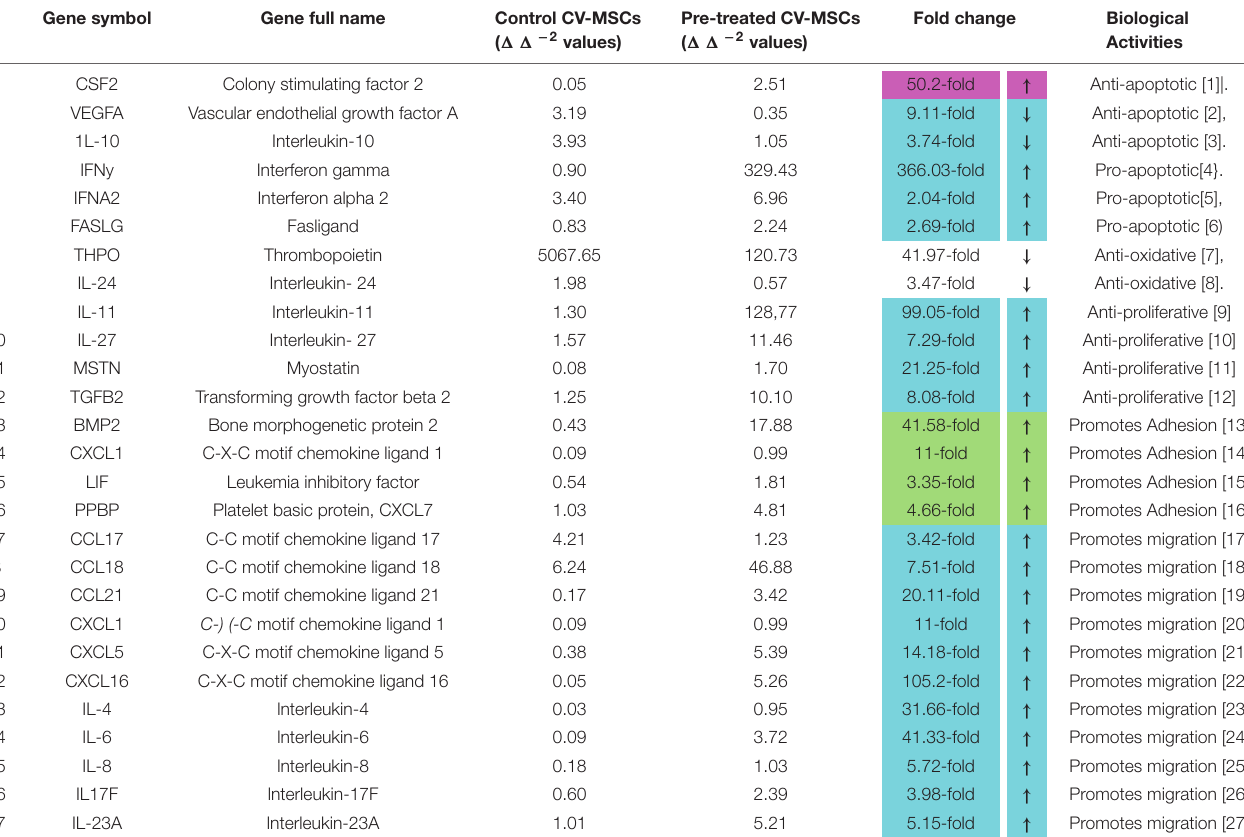
Differential gene expression observed in CV-MSCs after preconditioning for 72 h with CM-MDA231, and normalized with untreated controls. RT-PCR was performed using RT 2 profiler kit (Qiagen), as detailed in materials and methods. Three independent experiments were performed and data is expressed as fold change increase calculated from the (cid:49)(cid:49) − 2